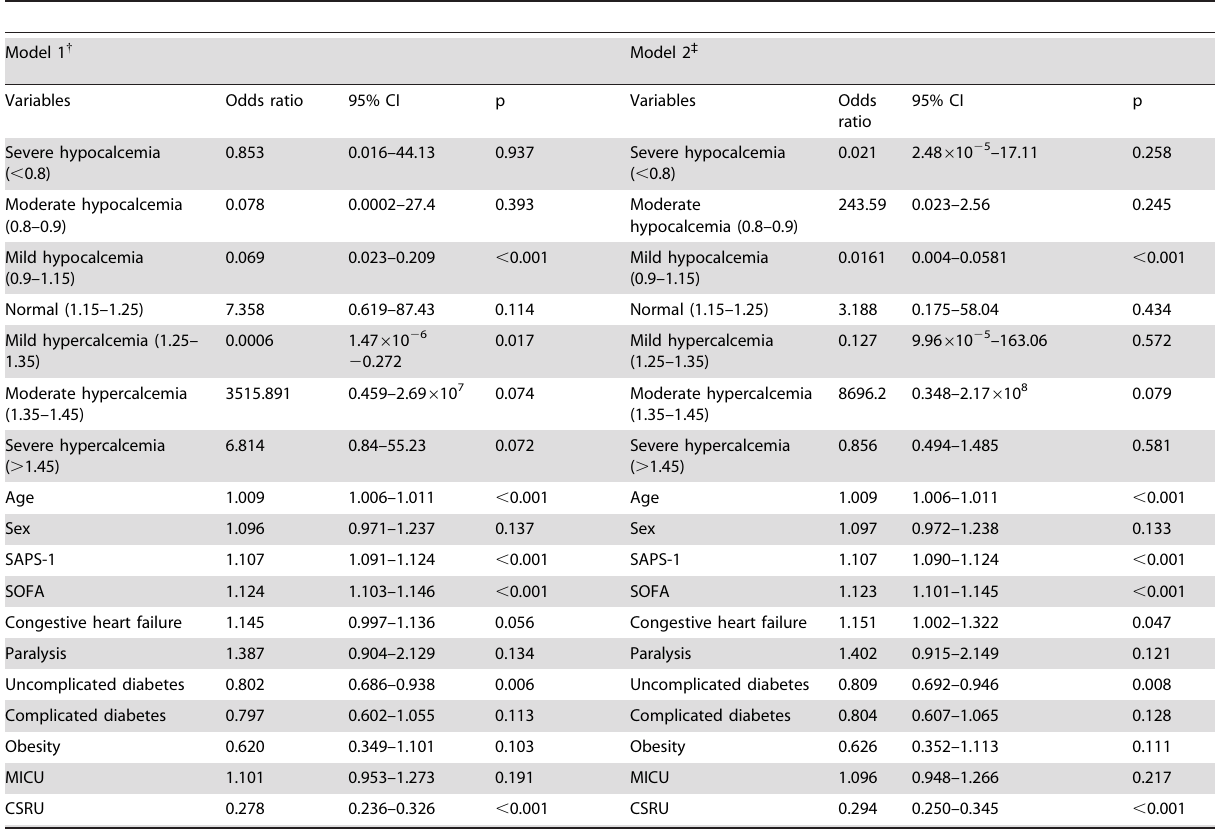
Table 3. Multivariable logistic regression categorizing calcium values into intervals by using linear spline